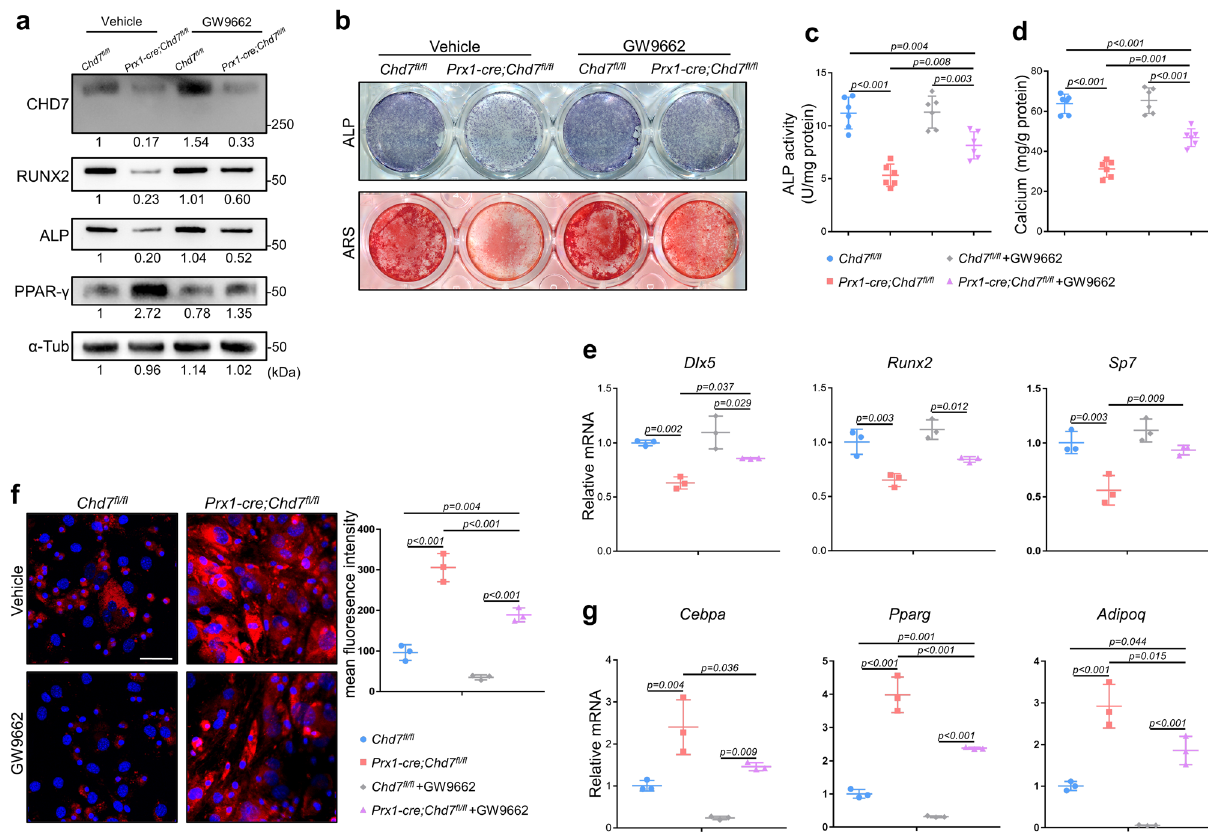
Fig. 6 PPAR- γ inhibition partially rescues the phenotype of Chd7 -de fi cient MSCs. a Western blot analysis and quanti fi cation of CHD7, RUNX2, alkaline phosphatase, and PPAR- γ in wild type and Chd7 -de fi cient bone marrow MSCs treated with vehicle or a PPAR- γ inhibitor (GW9662). b Representative images of ALP and ARS staining of treated MSCs. c Quantitative analyses of the ALP activity in treated MSCs ( n = 6 biologically independent MSC samples). d Quantitative analyses of the mineralization in treated MSCs ( n = 6 biologically independent MSC samples). e qRT-PCR analyses of the mRNA expression of Dlx5, Runx2 , and Sp7 in treated MSCs under osteogenic conditions ( n = 3 biologically independent MSC samples). f Representative images and quantitative analyses of Nile red staining in treated MSCs. Scale bar, 50 μ m ( n = 3 biologically independent MSC slides). g qRT-PCR analyses of the mRNA expression of Cebpa, Pparg , and Adipoq in treated MSCs under adipogenic conditions ( n = 3 biologically independent MSC samples). Data are shown as the mean ± S.D.; p value by one-way ANOVA with Tukey ’ s post hoc tests for multiple